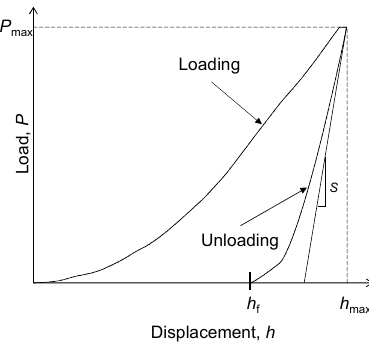
Figure 7. Schematic load-displacement graph during nanoindentation.